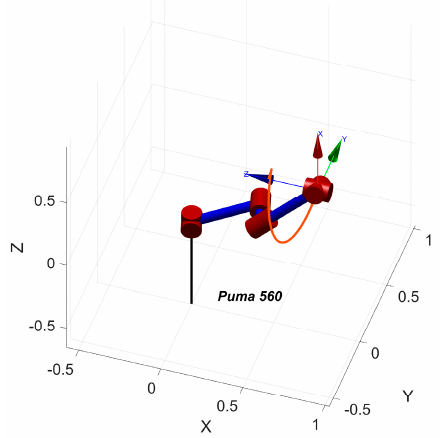
Figure 3. The motion trajectory of the Puma560 robot.